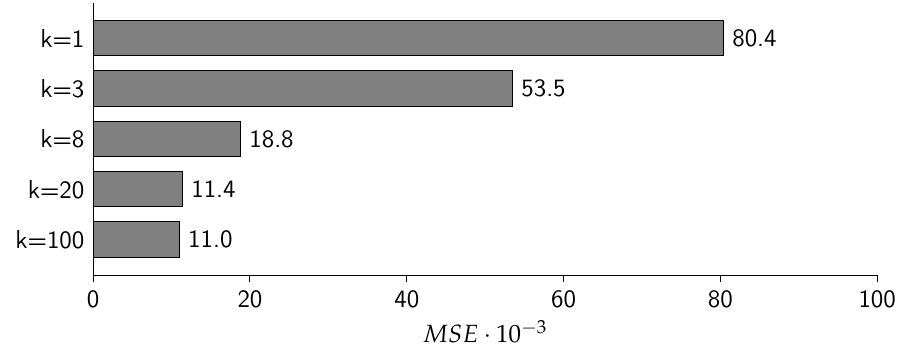
Figure 10. Mean square error.